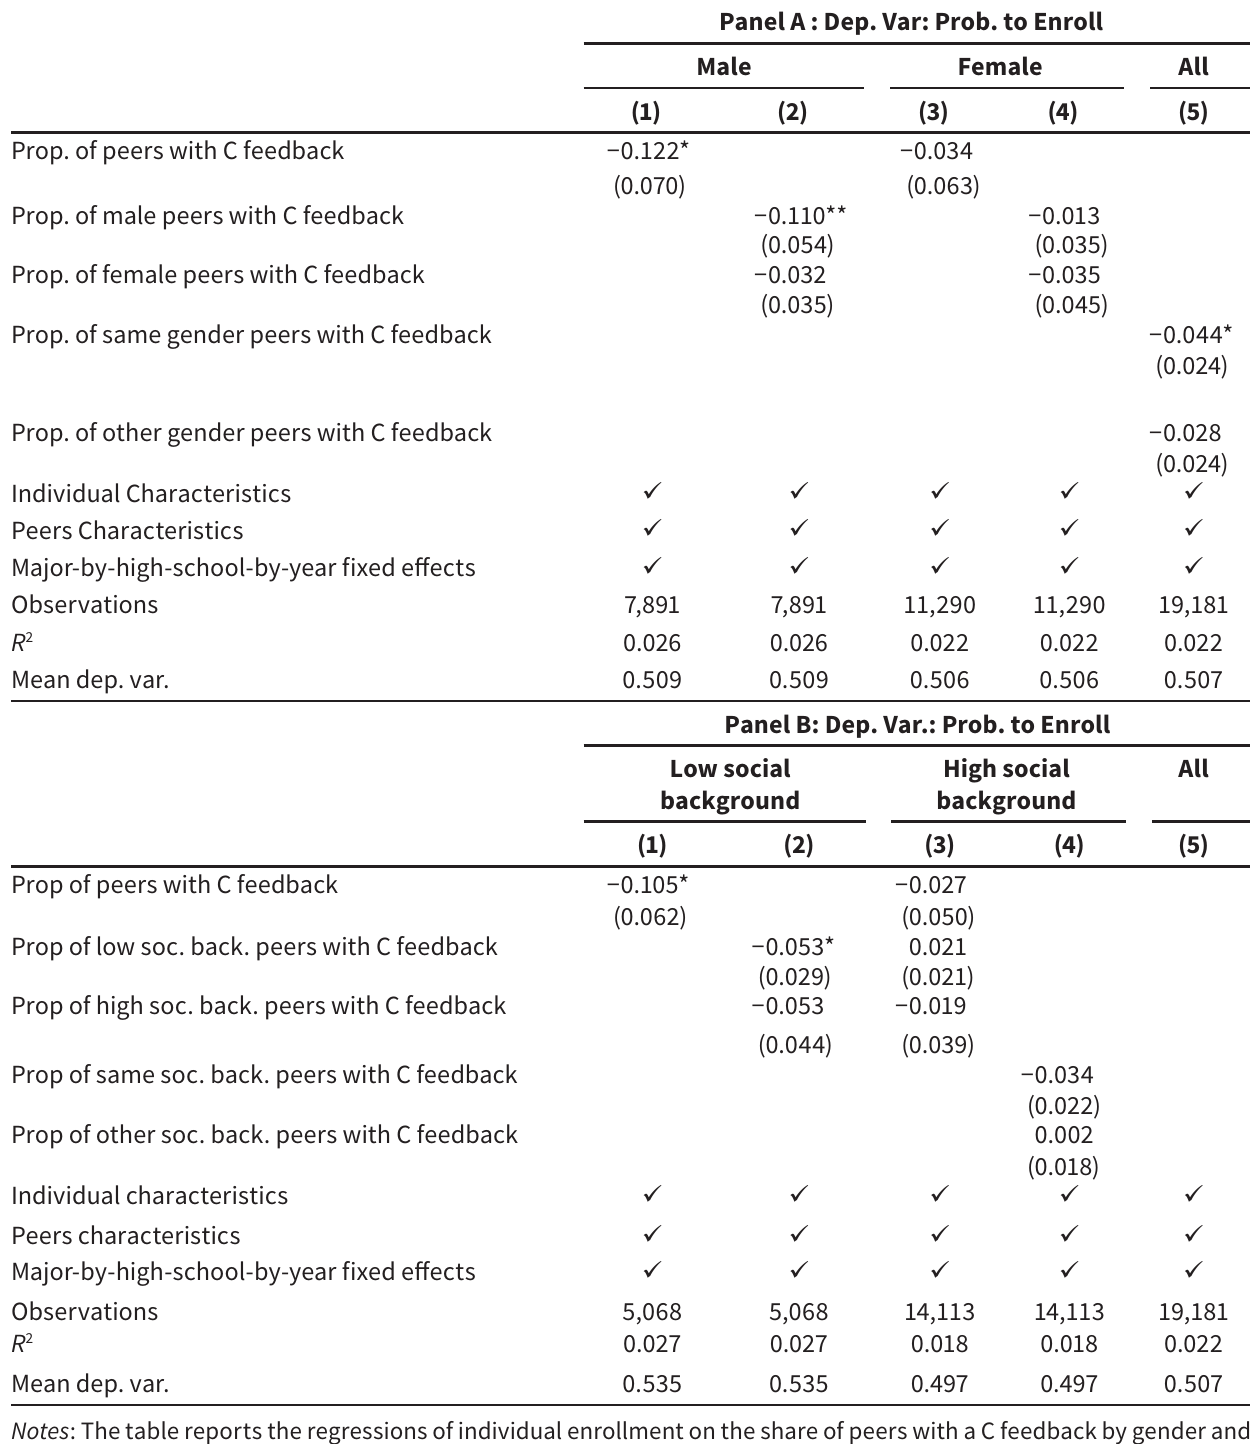
Heterogeneous effects: Regressions by gender and by social background